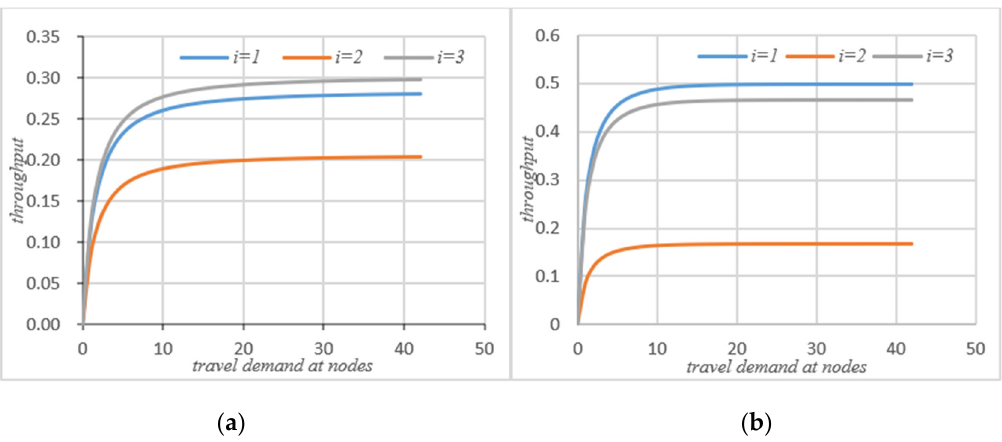
Figure 5. ( a ) Actual throughput without self-balance; ( b ) actual throughput with self-balance. As can be seen that after self-balancing, the actual throughput of node 1 has decreased, while the throughput of nodes 2 and 3 has increased significantly. According to Figure 8a, after the self-balancing of autonomous vehicles, the average throughput of nodes have increased significantly. Figure 6a,b compare the changes of service intensity at the nodes before and after the self-balancing of autonomous vehicles in the system under the same travel conditions. The horizontal axis represents travel demand and the vertical axis represents service